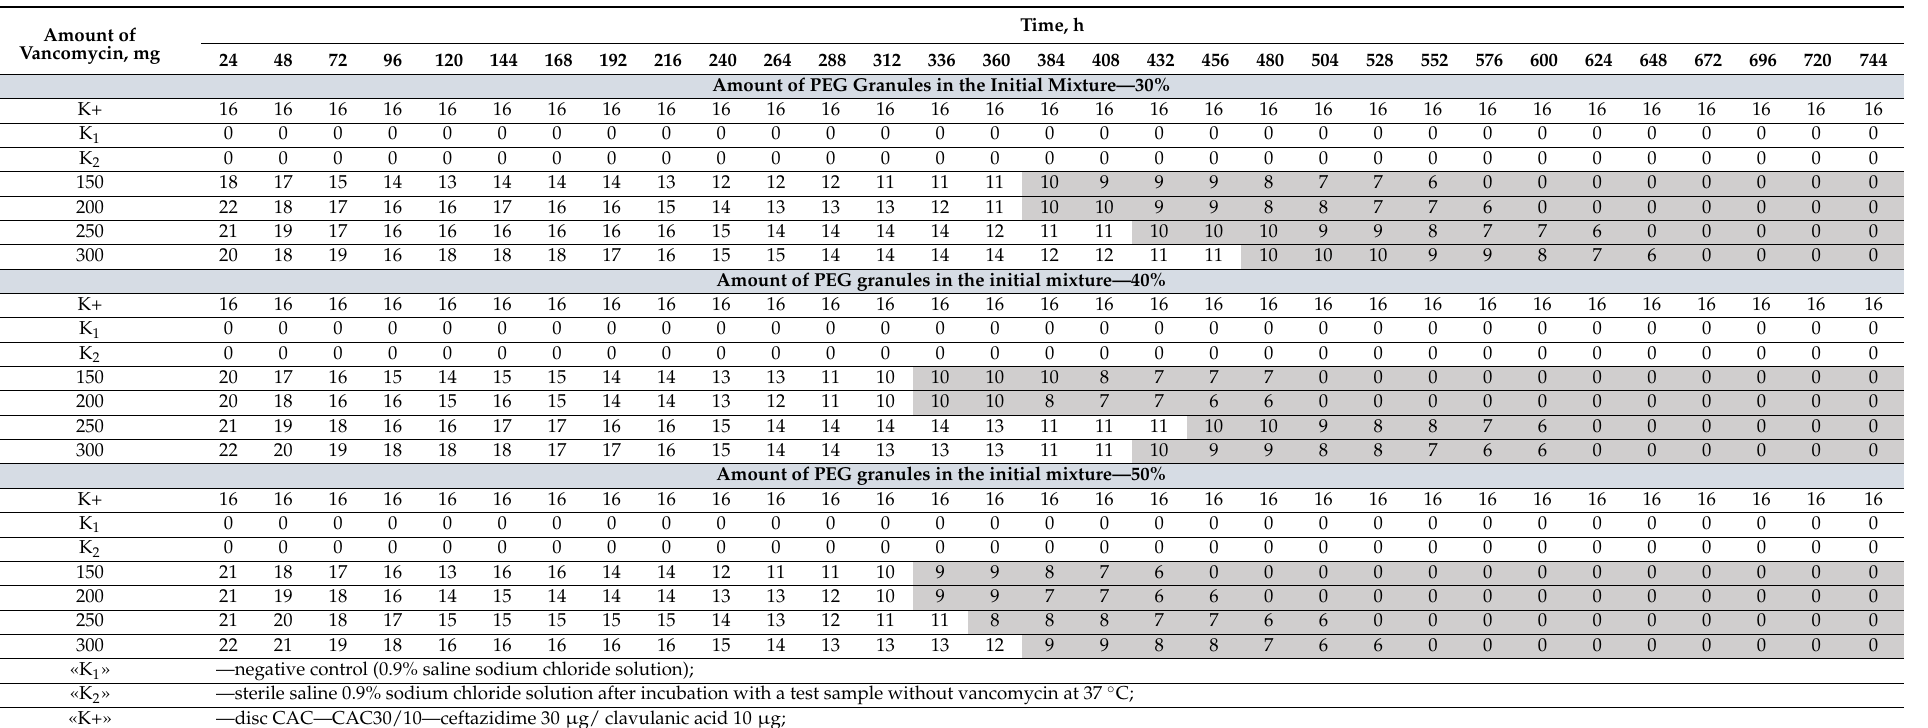
Table 2. Diameters of growth retardation zones of bacterial cultures of Staphylococcus aureus with chemically bonded ceramics containing vancomycin, in comparison with negative and positive